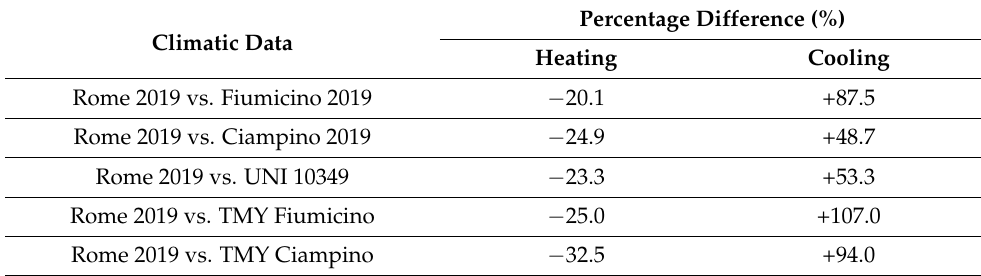
Table 4. Percentage differences in energy demands.